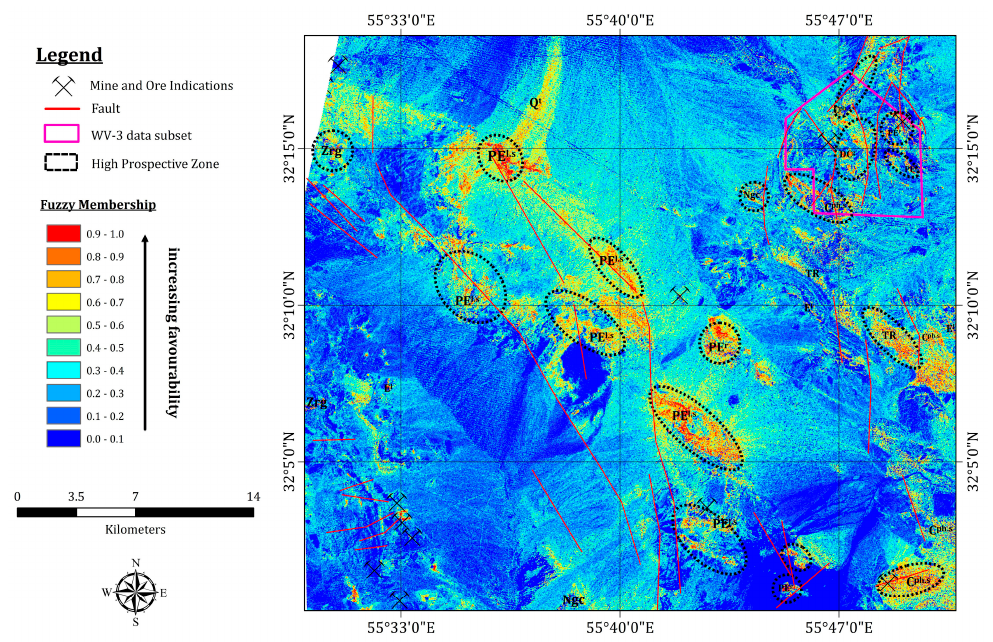
Figure 12. Mineral prospectivity map of the study area at regional scale derived from Landsat-8, Sentinal-2 and ASTER selected alteration thematic layers. Magenta polygon delineates WV-3 imagery.